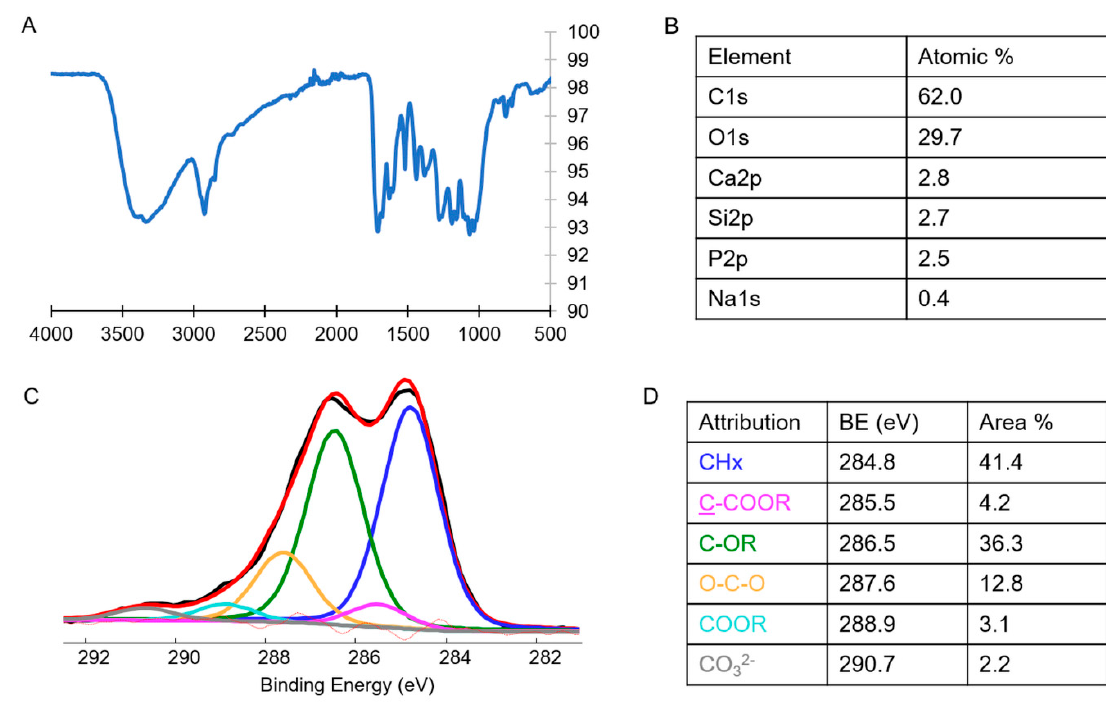
Figure 2. FT ‐ IR/ATR spectrum ( A ), XPS surface atomic composition ( B ), XPS C1s signal curve fitting ( C ), and curve ‐ fitting data ( D ) of OFE. The maximum error on the BE values was equal to ± 0.2 eV.